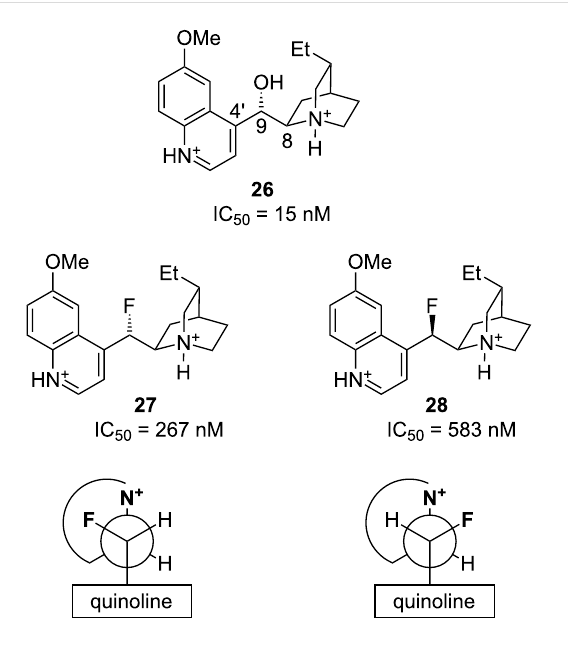
Figure 5: Dihydroquinidine ( 26 ) and fluorinated analogues 27 and 28 . Newman projections along the C9–C8 bonds of 27 and 28 show the proposed bioactive